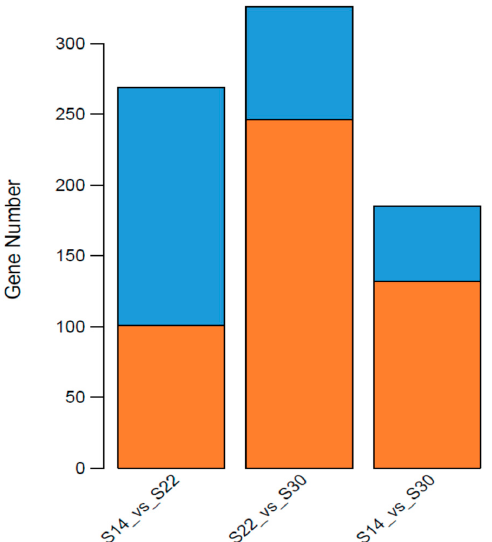
Figure 2. Number of differentially expressed genes (DEGs) of Anadara kagoshimensis among different salinity treatments. The x-axis represents the pairwise comparisons, and the y-axis shows the number of DEGs screened. Orange bars denote up-regulated genes, and blue bars indicate down-regulated genes.